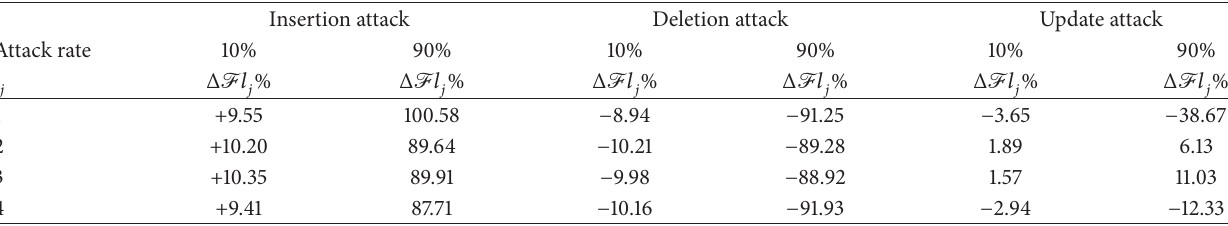
Table 13: Characterization of malicious modifications on length of data values.